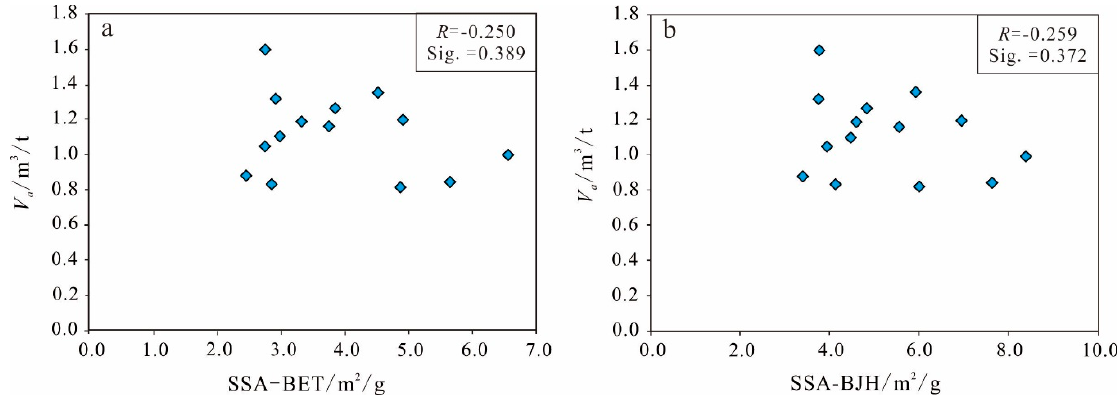
Figure 17. Influence of specific surface area on AGC in shales. ( a ) Correlation between V a and SSA based on BET model; ( b ) correlation between V a and SSA based on BJH model.